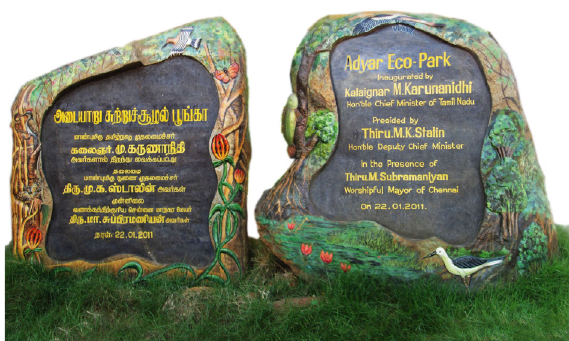
Image 11. These are large stones with carvings and paintings of wildlife and vegetation designed for the then Chief Minister of Tamil Nadu, M. Karunanidhi’s inauguration of the Adyar Eco Park. Wildlife depicted: Black-rumped Flameback Woodpecker Dinopium benghalense , Hoopoe Upupa epops , Lime Butterfly Papilio demoleus , Peacock Pansy Junonia almanae , Climbing Perch Anabas testudineus , Painted Stork Mycteria leucocephala and Black-winged Stilt Himantopus himantopus . Adyar Eco Park, Chennai.